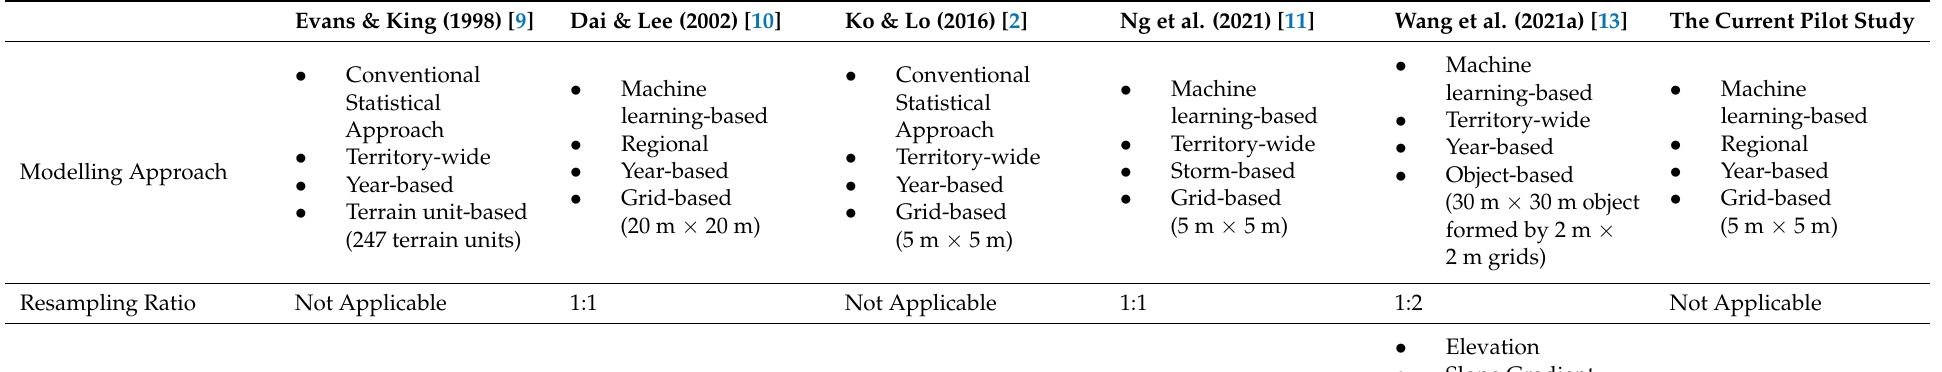
Table 1. Summary of Landslide Susceptibility Studies in Hong